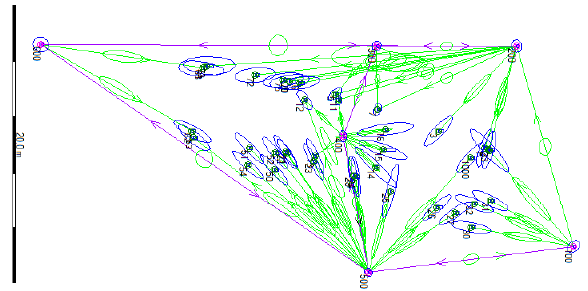
Figure 11. Geodetic network layout.